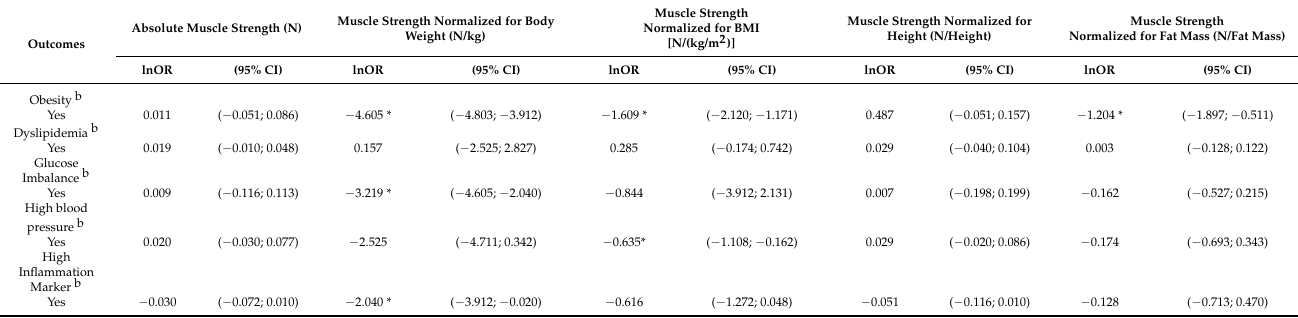
Table 1. Adjusted a association from binary logistic regression between muscle strength and cardiometabolic risk factors among